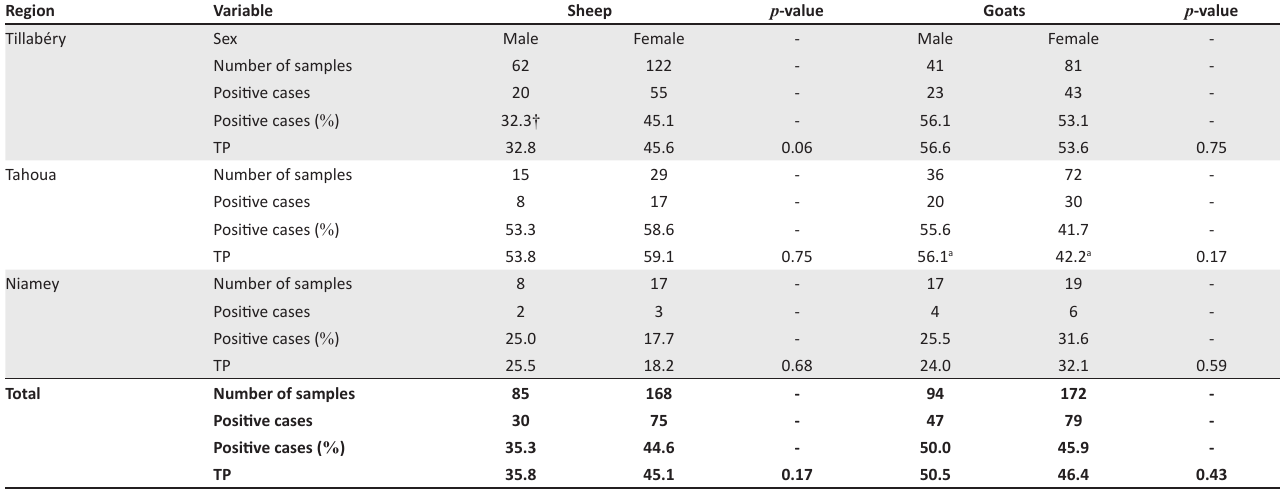
TABLE 5: Prevalence of peste des petits ruminants in sheep and goats according to sex.